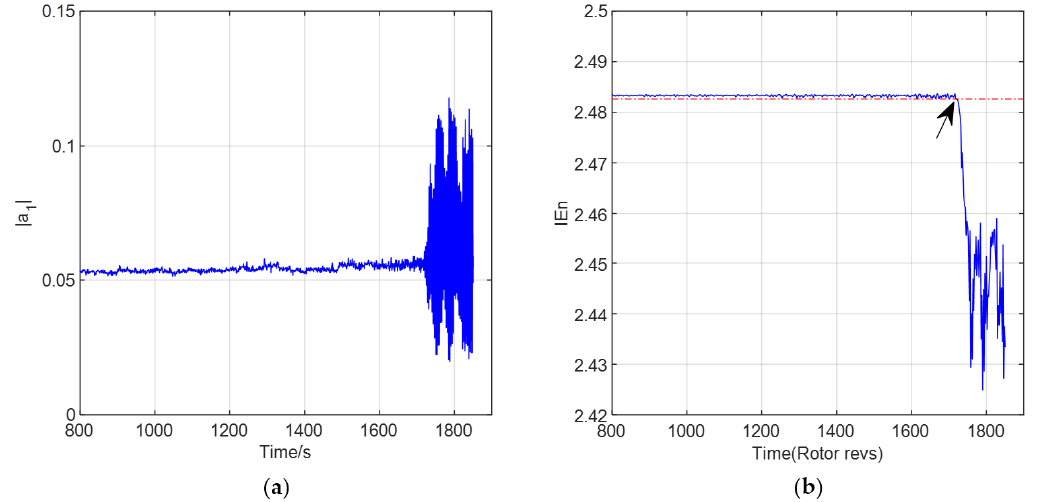
Figure 9. Information entropy of the spatial mode at 3000 rpm: ( a ) First-order space mode; ( b ) Infor- mation